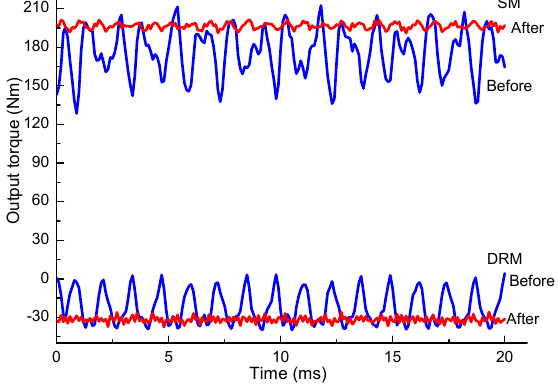
Figure 17. Output torque comparison of SM and DRM before and after optimization.